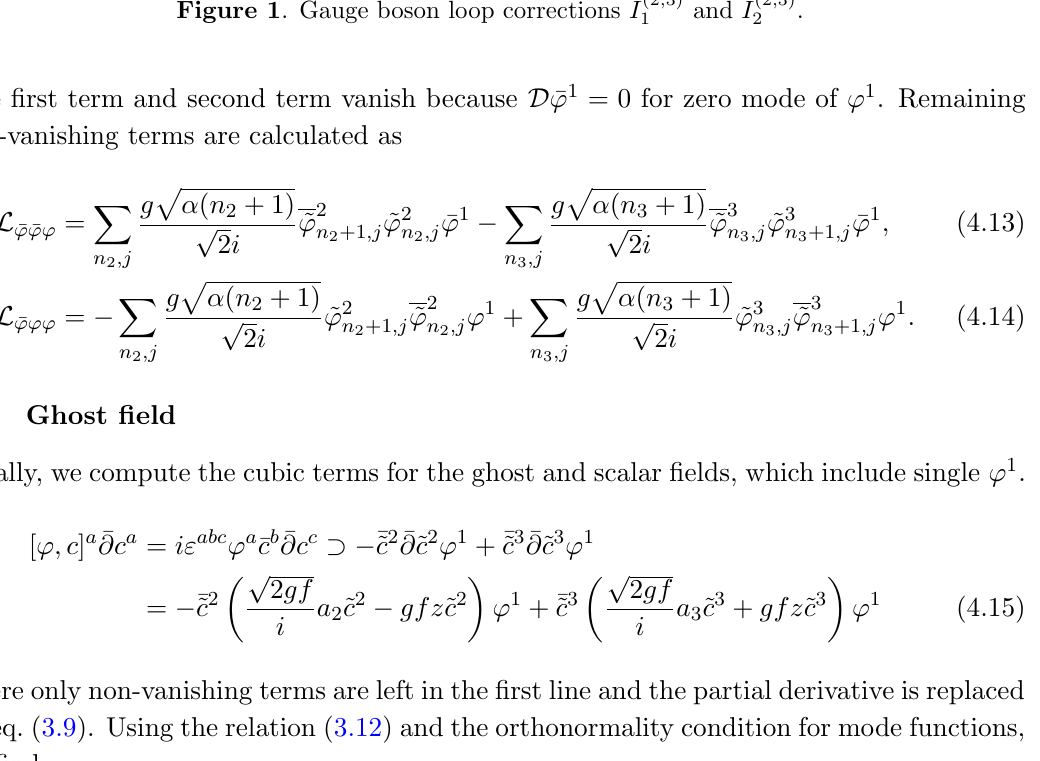
Figure 1 . Gauge boson loop corrections I (2 , 3)